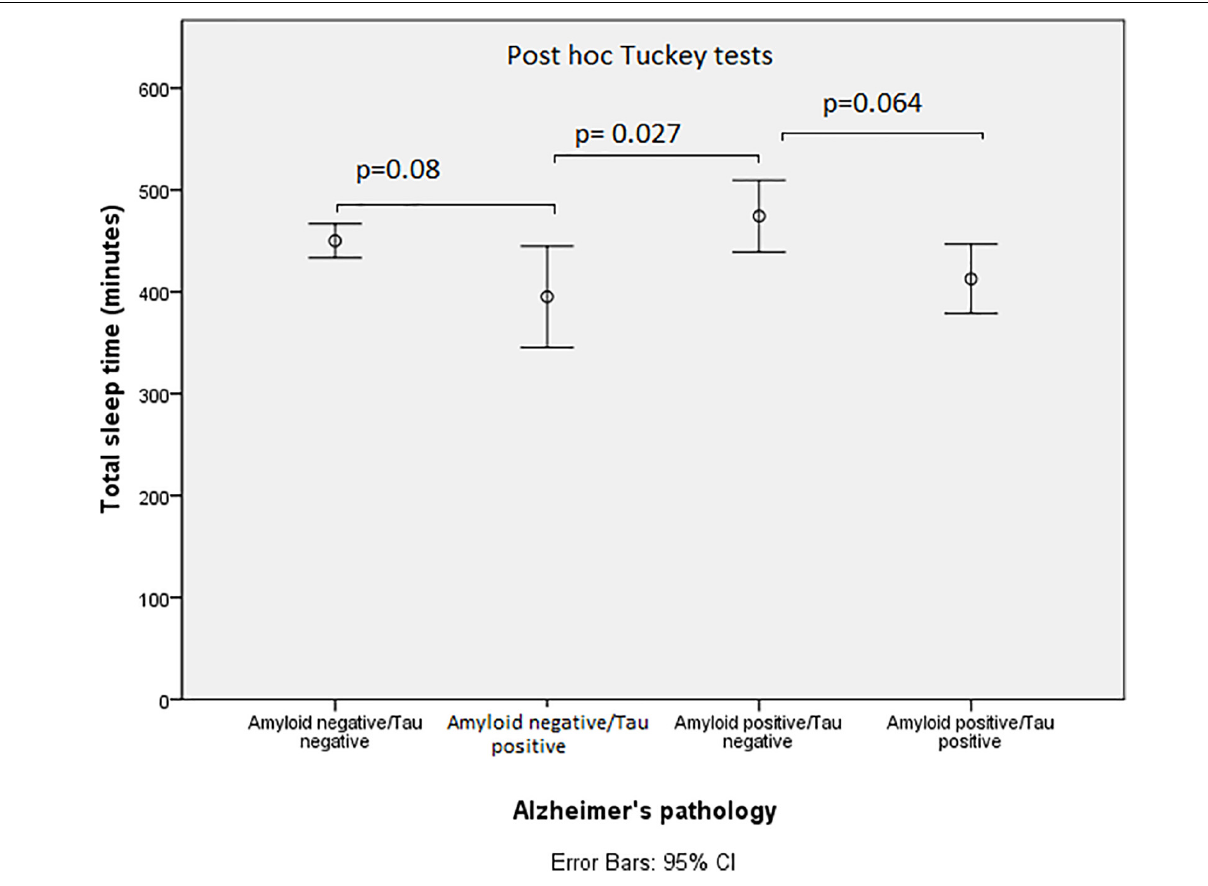
( β = 0.78; p = 0.021) ( Table 2 ). In Figure 3 , the stratified analysis by APOE ε 4 shows that the correlation between total sleep time with t-tau is mainly due to the APOE ε 4 carriers.